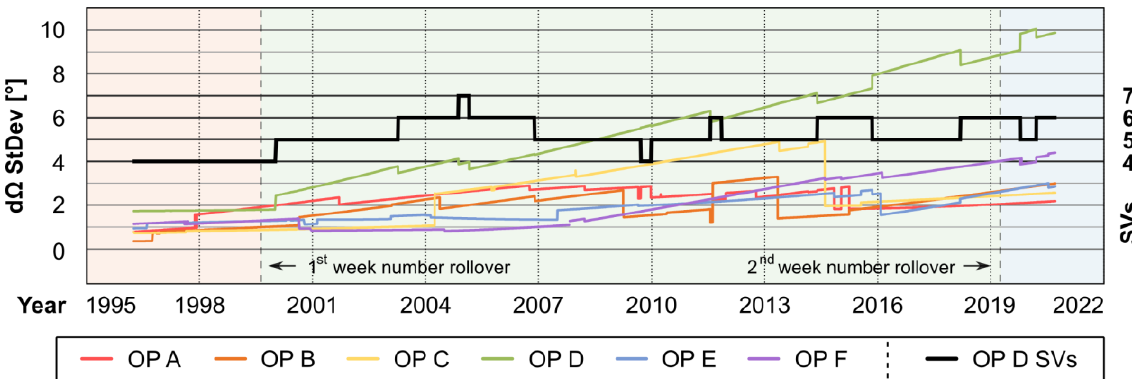
Figure 8. Standard deviations of the OPs’ dΩ parameter.